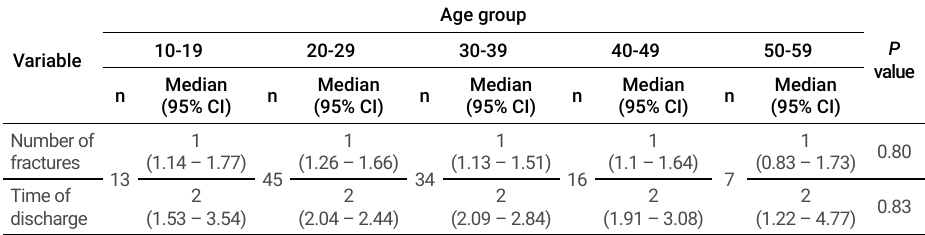
Table 4. Difference of medians of the number of fractures and time of hospital discharge according to the age group in maxillofacial trauma patients.